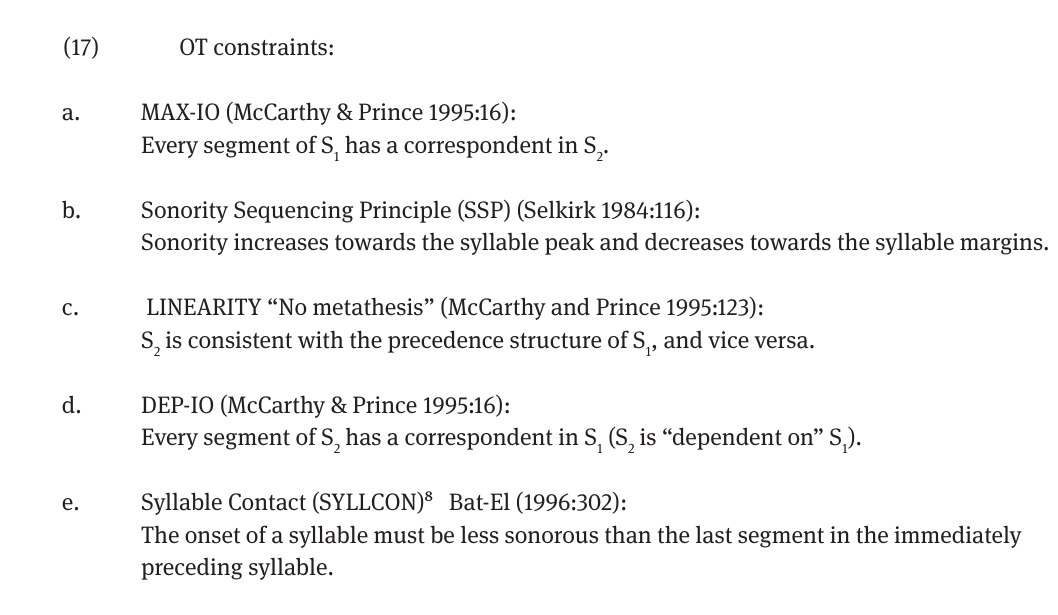
Table 5: MAX-IO, SSP, SYLLCON>>LINEARITY>>DEP-IO